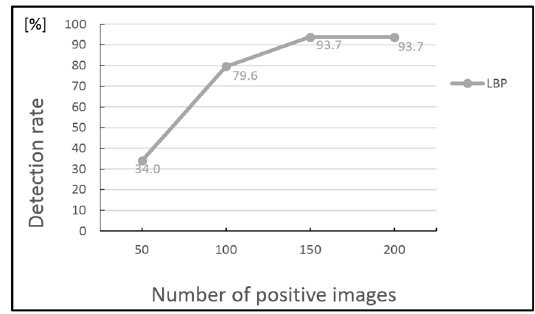
Figure 7. Change in detection rate when 1000 negative images were used and the positive images were increased from 50 to 200.